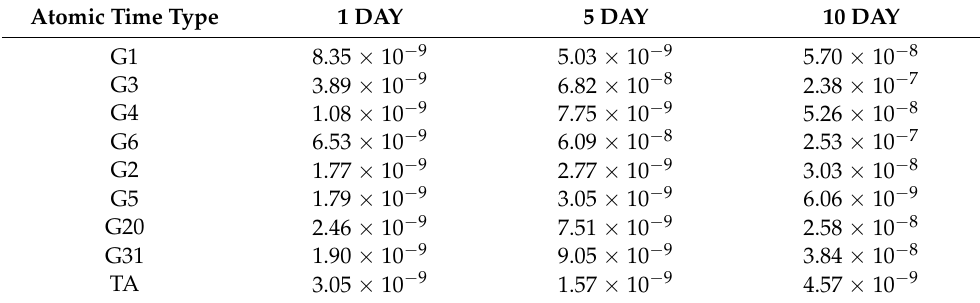
Figure 17and Table 3 below: Table 3. Clock prediction